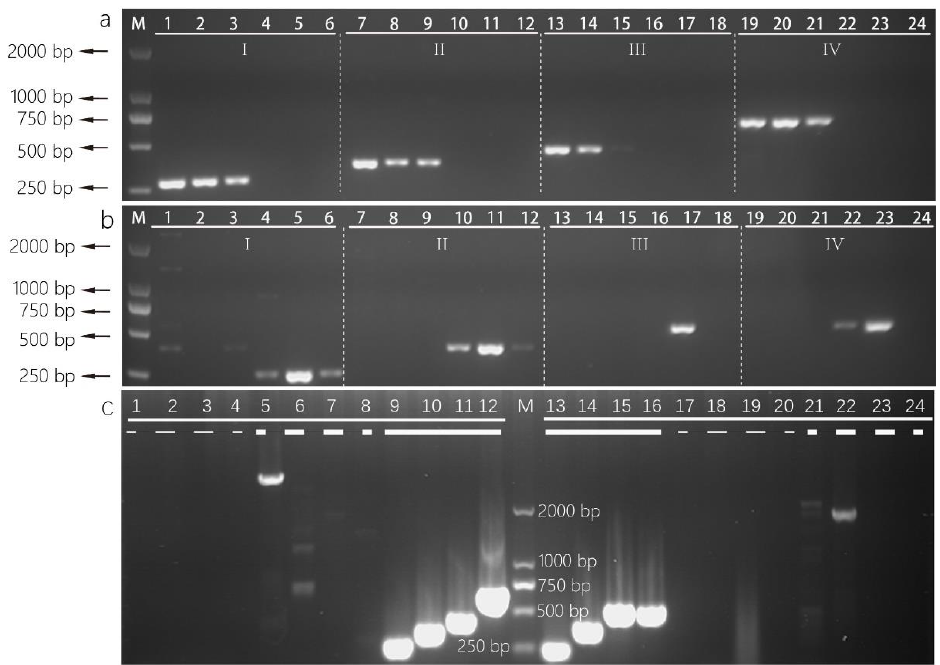
Figure 3. Evaluation of specificity of primers based on orphan genes from Aspergillus spp. ( a ) Primers used in lane groups I-IV, respectively, are aOP1, aOP2, aOP3 and aOP4; ( b ) primers used in lanes groups I-IV respectively are iOP1, iOP2, iOP3, iOP4. Lane M: 2000 bp ladder, samples in lanes group, I-IV respectively, are A. chevalieri L1, L2 and H7 and A. cristatus L3, L4 and H6; ( c ) negative controls and positive controls for each pair of primers; thin dotted line, respectively, represents no template controls, bold dotted line represents negative controls, bold line represents positive controls, lanes 1 – 12 respectively, are primers aOP1, aOP2, aOP3 and aOP4 and for target A. chevalieri , lanes 13 – 24 respectively, are primers iOP1, iOP2, iOP3 and iOP4 for target A. cristatus .